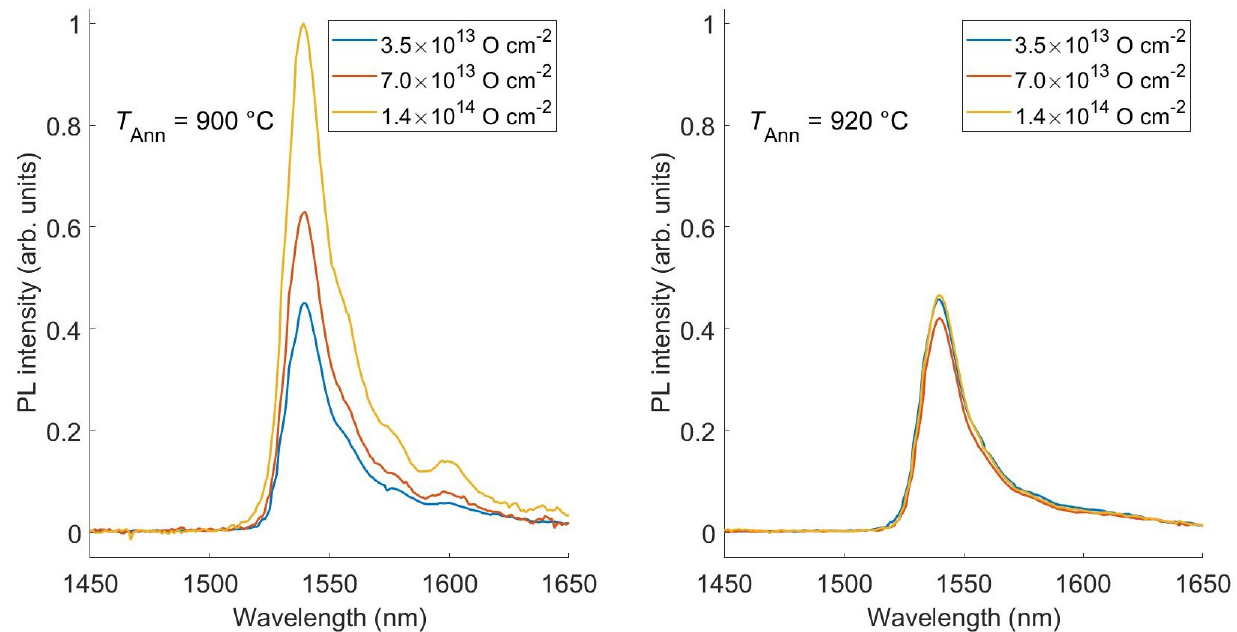
Figure 3. Photoluminescence spectra recorded for three different oxygen co-doping doses. On the left, samples are annealed for 30 min at a temperature T Ann = 900 °C. On the right, the annealing is performed at 920 °C for the same amount of time. All the signals are normalized with respect to the PL maximum obtained with a dose equals to 1.4 × 10 14 O cm − 2 and the annealing temperature equals to 900